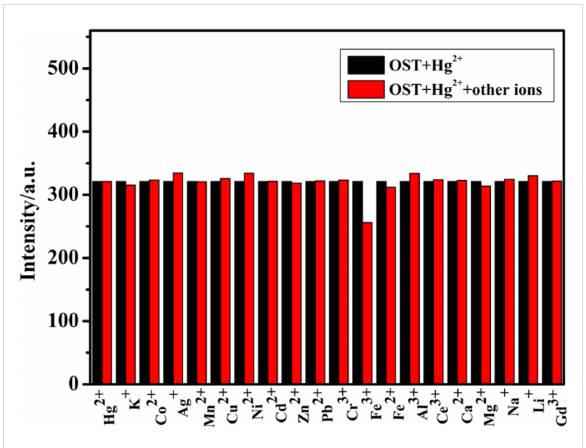
Figure 2: Metal ion selectivity of OST–Hg 2+ ( c = 3.0 × 10 − 5 mol ∙ L − 1 ) in the presence of 1.2 × 10 − 4 mol ∙ L − 1 of various metal ions (H 2 O/CH 3 OH 97:3, v/v, λ ex = 325